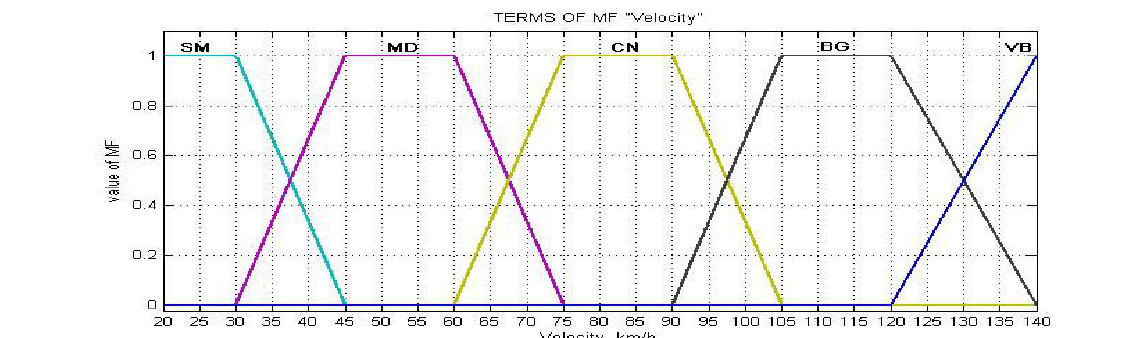
Fig. 7. Term-sets SM, MD, CN, BG, VB of linguistic variable